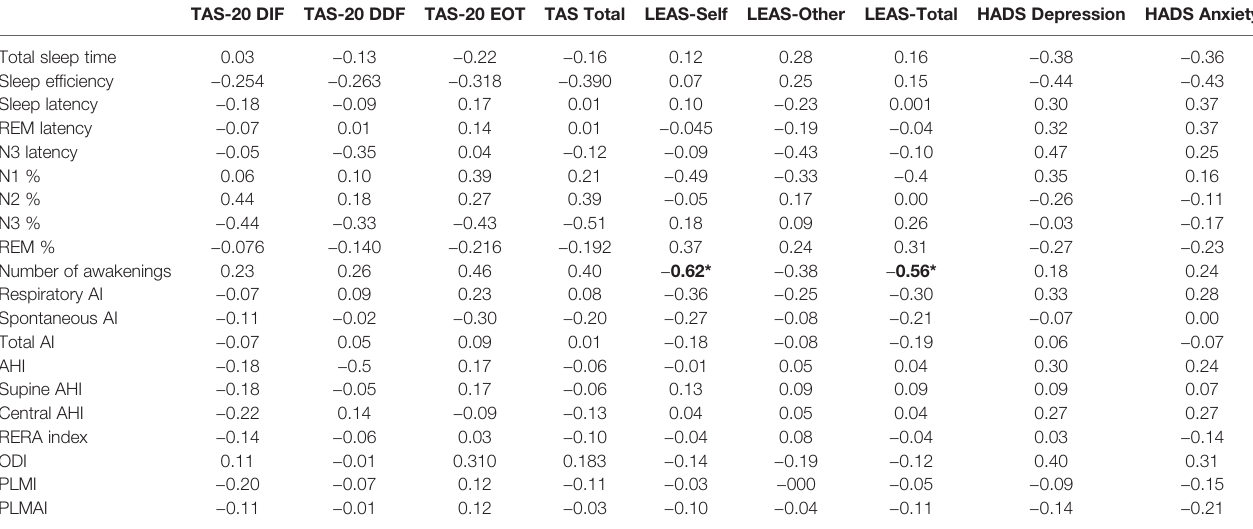
TABLE 4 | Results from Spearman correlation analysis with r-values between sleep parameters from polysomnography and questionnaires TAS-20, LEAS and HADS, respectively, in ME/CFS